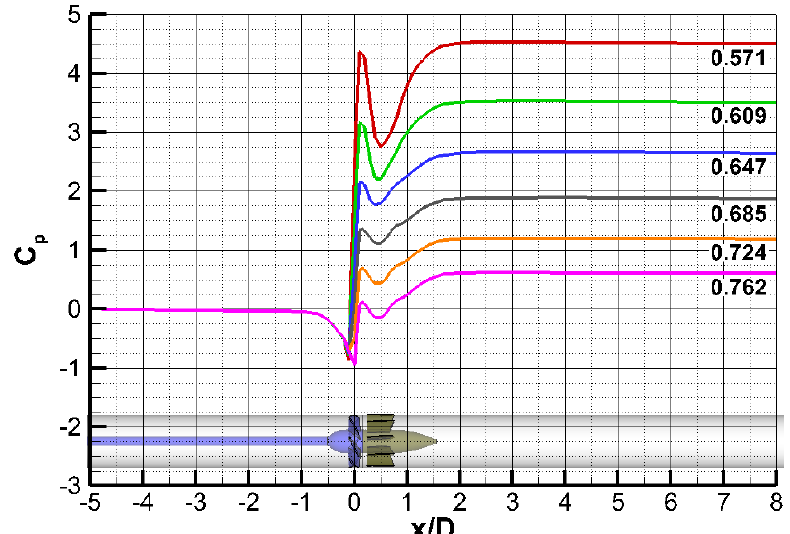
Figure 6. Pressure distributions on the tunnel wall by C Q .